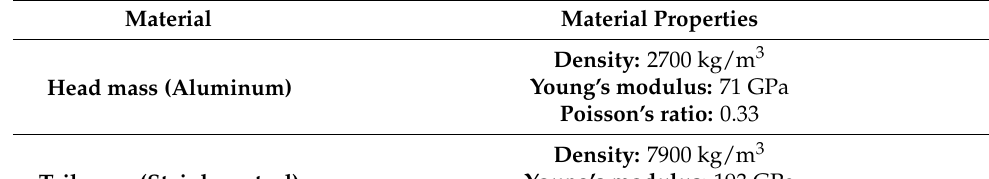
Table 3. Material properties of the Tonpilz transducer.